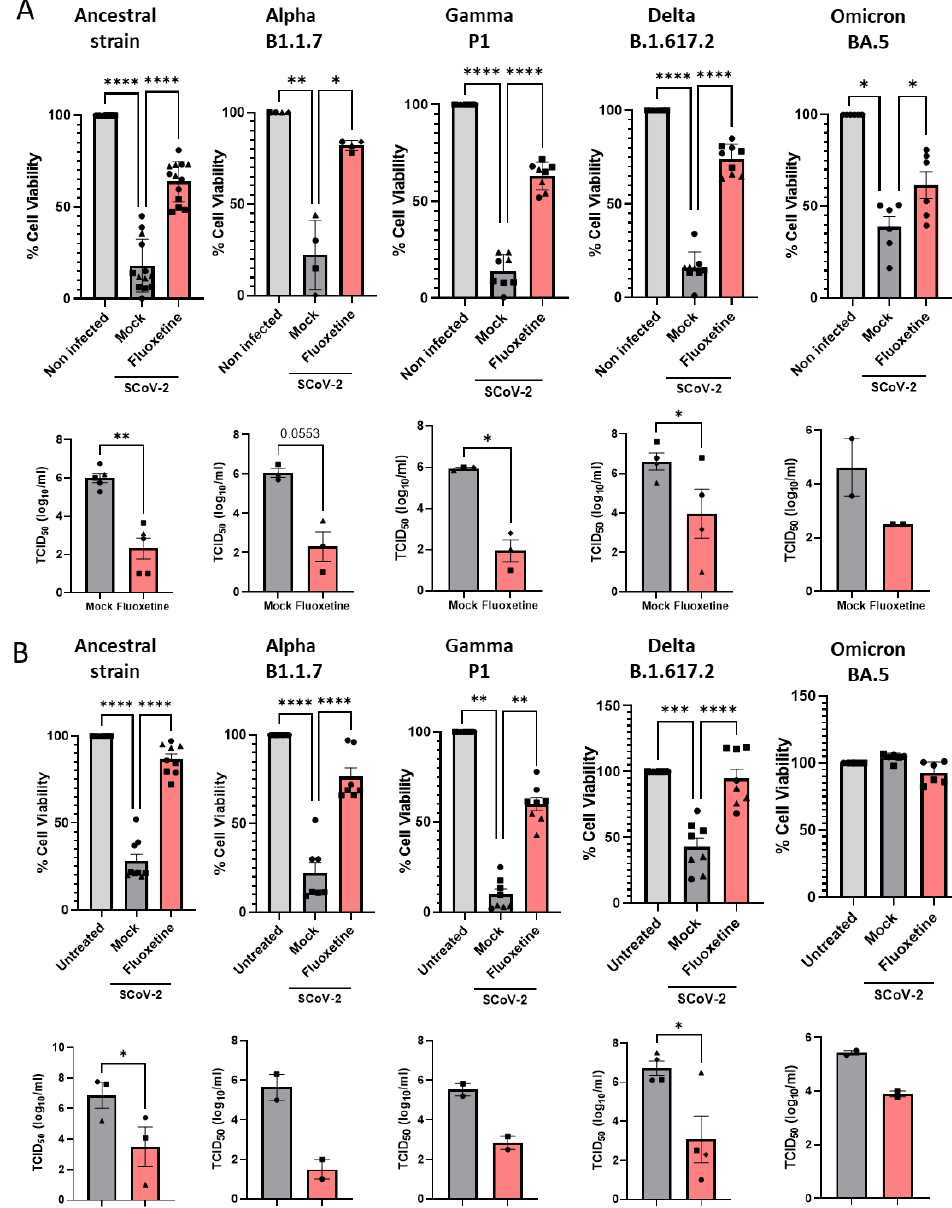
Figure 3. Fluoxetine activity on SARS-CoV-2 variants in vitro. ( A ) Activity of fluoxetine (12.5 µM) or mock (water) in Vero E6 cells infected with SARS-CoV-2 (Pasteur, B.1), B.1.1.7 (UK), P1, B.1.617 (Delta) and BA.5 (Omicron) variants measured by assessing cell viability and viral load. ( B ) Antiviral activity of fluoxetine (12.5 µM) measured in A549 cells expressing hACE2-TMPRSS2 infected with SARS-CoV-2 (Pasteur, B.1), B.1.1.7 (UK), P1, B.1.617 (Delta) and BA.5 (Omicron) variants measured by cell viability and viral load. Representative of two to seven independent experiments, data are expressed as mean + SEM. *, p < 0.05, **, p < 0.01; ***, p < 0.001; ****, p <